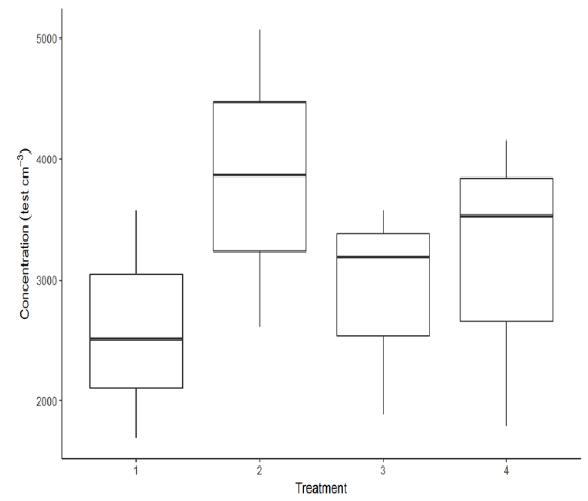
Figure 3. Boxplots showing the concentration of testate amoebae after the different treatments. (1 = water-based preparation; 2 = dispersant; 3 = mild alkaline + acetone; 4 = a combination of dispersant and alkaline +